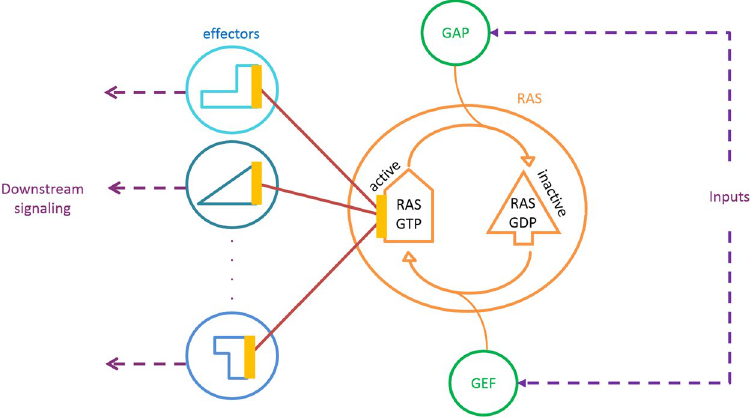
Figure 1. Schematic representation of RAS protein conformational states. In the active form, RAS can bind to its effectors and activate different signalling